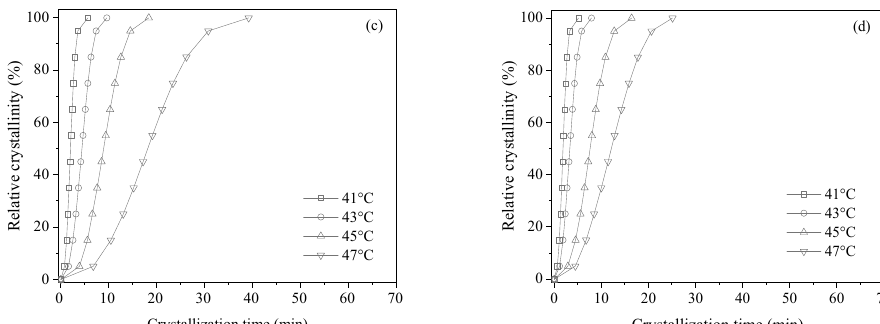
where X t is relative crystallinity formed at crystallization time ( t ), n is the Avrami expo- nent, and k is the crystallization rate constant [36–39]. Figure 5 depicts the Avrami plots for all samples, from which the experimental X t data were well fitted by the Avrami equa- tion with different Avrami parameters.